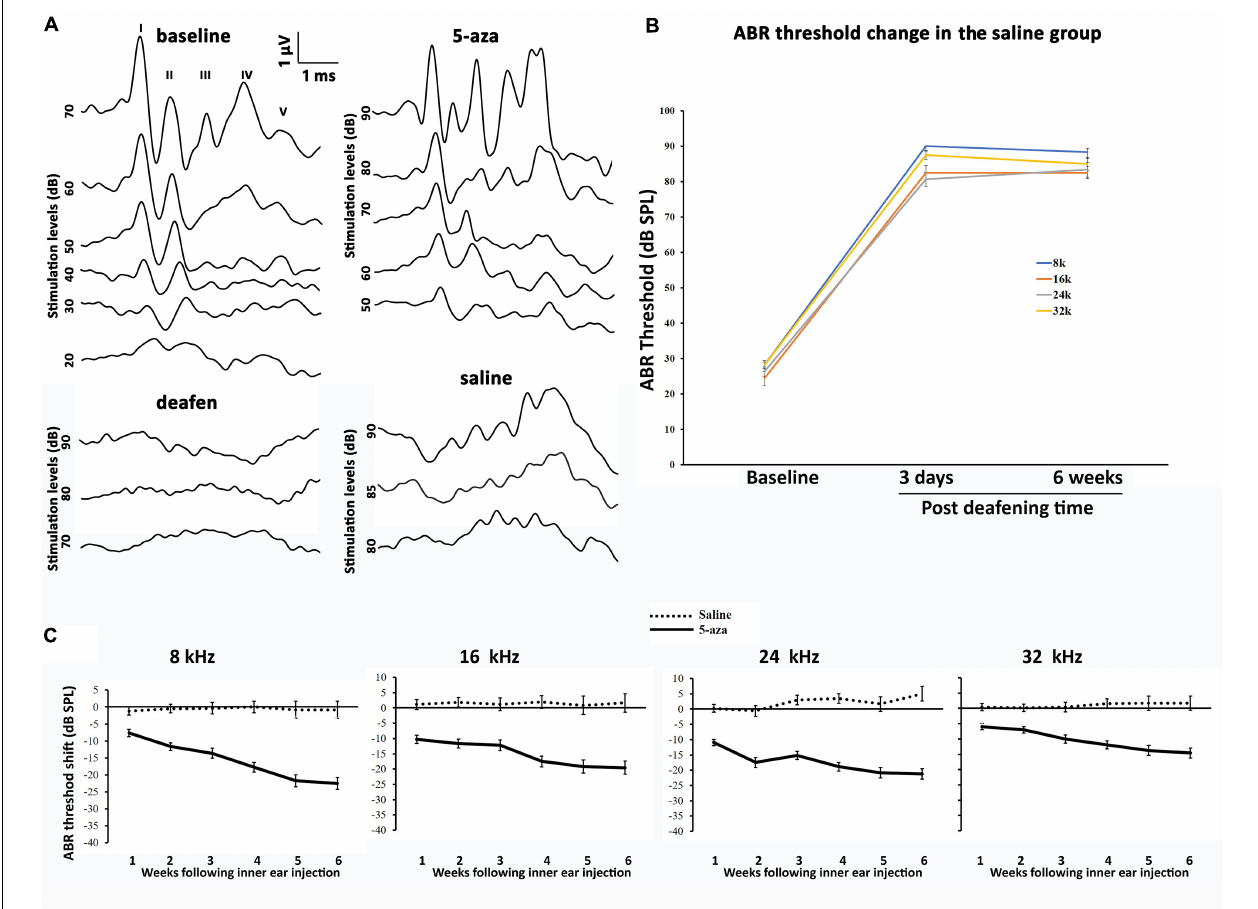
FIGURE 3 | Auditory brainstem response (ABR) thresholds in the 5-aza- and vehicle-treated mice. (A) Representative ABR waveforms of four groups of mice. ABR threshold was determined by the lowest stimulation dB sound pressure level (SPL) that generates the amplitude of wave I greater than 0.2 µ V. The baseline threshold was about 30 dB in this figure. Three days after deafening, deafened mice showed no ABR response up to 90 dB SPL stimulation. Two weeks after 5-aza treatment, ABR trace showed a threshold of 50 dB SPL. In contrast, the vehicle-treated mouse showed messy traces without typical ABR waveform responses. (B) ABR threshold shifts were over 40 dB SPL 3 days after deafening in the saline group. The threshold shifts remained 6 weeks following deafening. (C) ABR threshold shifts trend for up to 6 weeks after surgery in the 5-aza and vehicle groups at 8, 16, 24, and 32 kHz. Negative values in the 5-aza group revealed hearing improvement. ABR threshold shifts in the vehicle group were close to zero, indicating that vehicle injection did not significantly change ABR threshold. Data are means ± SEM.